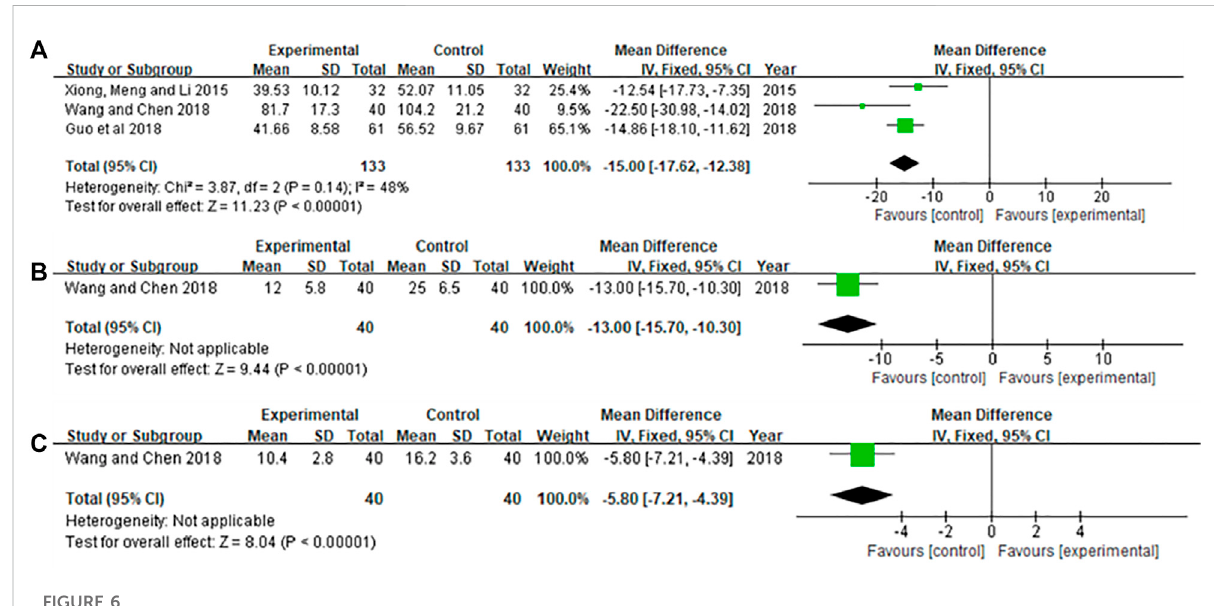
FIGURE 6 Meta-analysis of in fl ammation factors. (A) TNF- α ; (B) IL-6; (C)